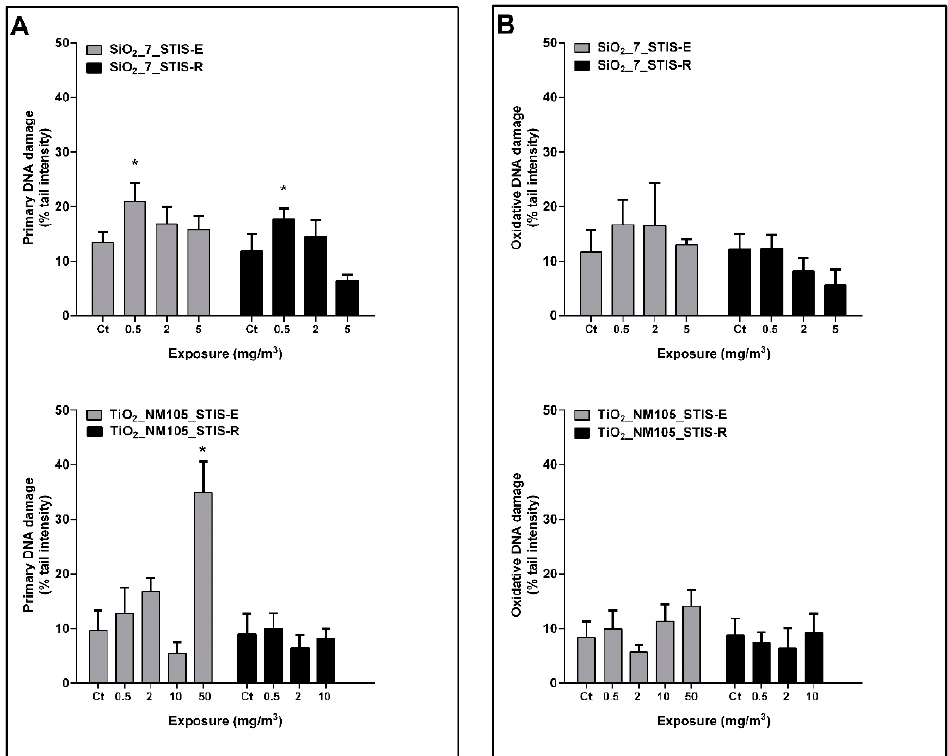
Figure 3. Primary ( A ) and oxidative ( B ) DNA damage in the rat lung tissue following short-term inhalation exposure (STIS) to aerosolized SiO 2 _7 (0.5–5 mg/m 3 ) and TiO 2 _NM105 (0.5–50 mg/m 3 ), assessed by the comet assay at 5 days after the initial exposure (exposure group; STIS-E) and after a recovery period of 21 days (recovery group; STIS-R). Percentage of DNA in the tail (% tail intensity) was used as DNA damage descriptor. Columns represent mean and error bars are the standard deviation (SD); Ct (negative control). * p < 0.05 vs.